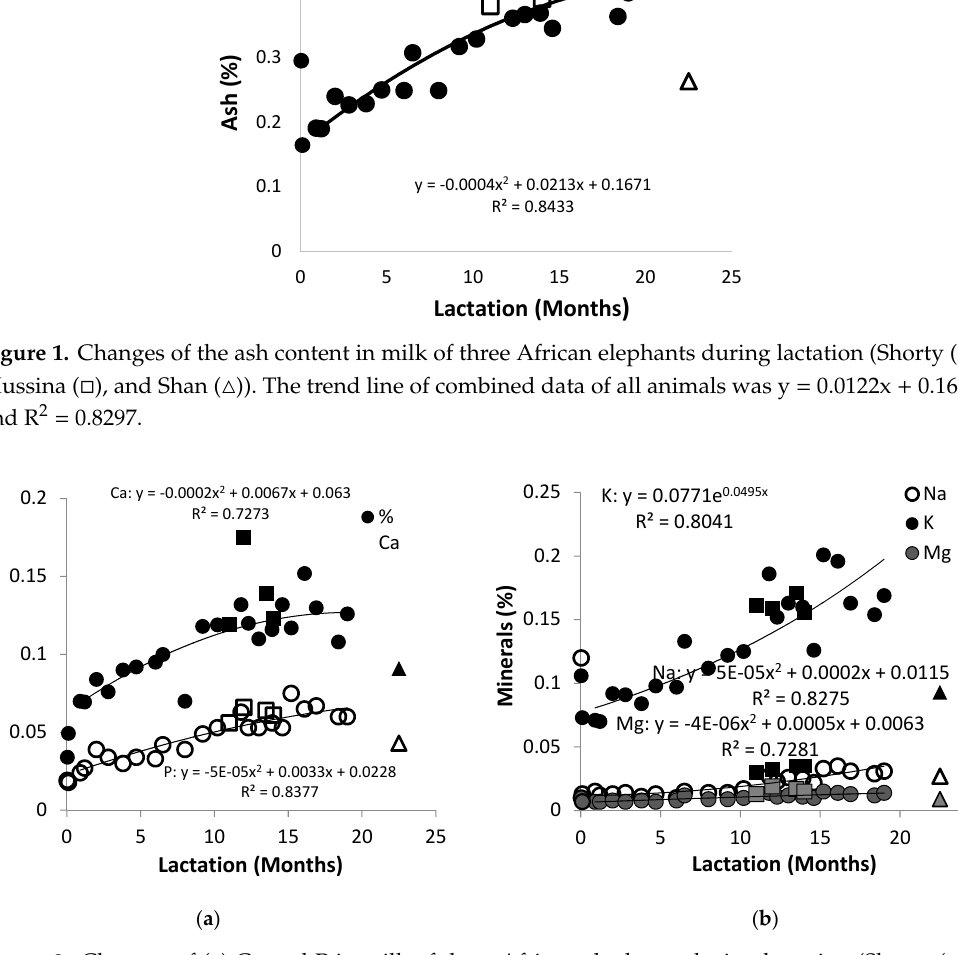
Figure 2. Changes of ( a ) Ca and P in milk of three African elephants during lactation (Shorty ( ○● ), Mussina ( □■ ), and Shan ( Δ ▲ )) and ( b ) Na, K, and Mg (Shorty ( ○ ● ● ), Mussina ( □■■ ), and Shan ( Δ ▲▲ )). The trend lines for combined data of all animals were y = − 0.0005x 2 + 0.0314x + 0.053 and R 2 = 0.7023 for Ca, y = − 0.0004x 2 + 0.0589x + 0.0228 and R 2 = 0.8213 for P, y = 0.0071x + 0.073 and R 2 = 0.7981 for K, y = 0. 5 x 2 + 0.0007x + 0.0115 and R 2 = 0.8151 for Na, and y = 0.000005x 2 + 0.0005x + 0.0063 and R 2 = 0.7182.